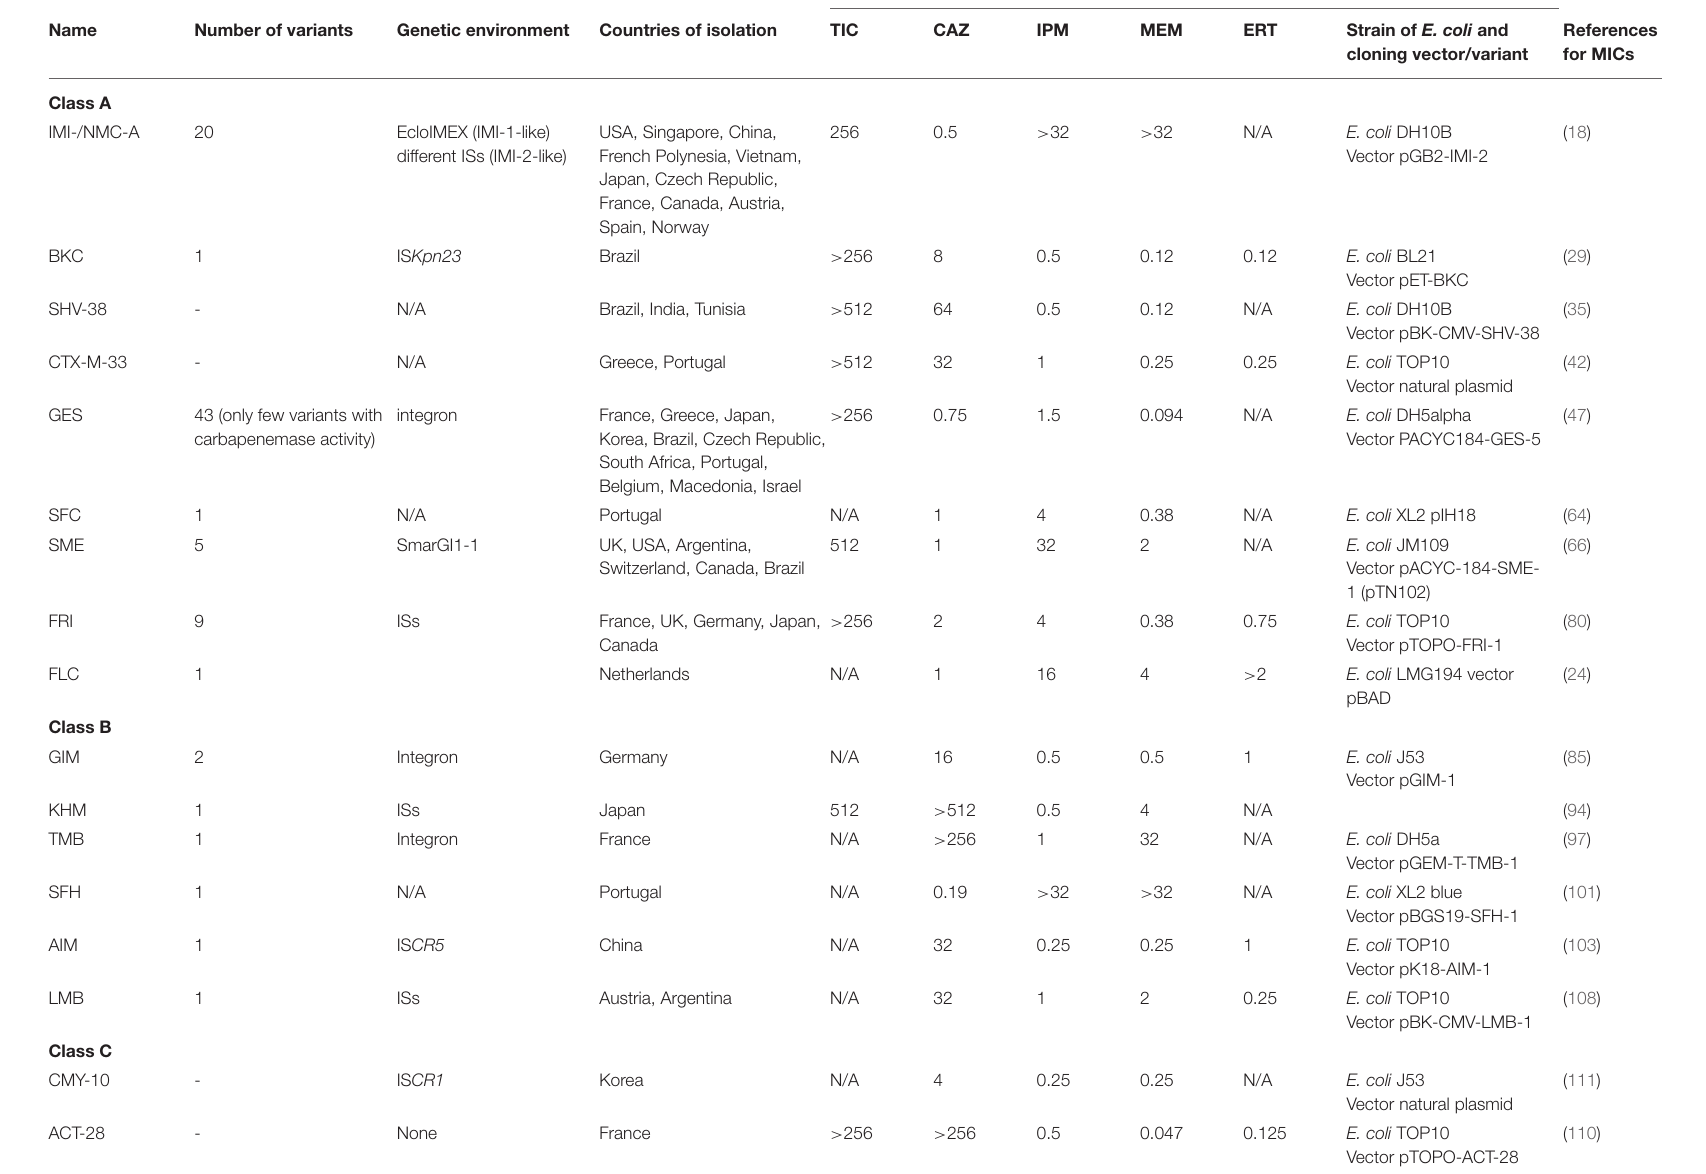
MICs of β -lactams in cloning vector in E. coli